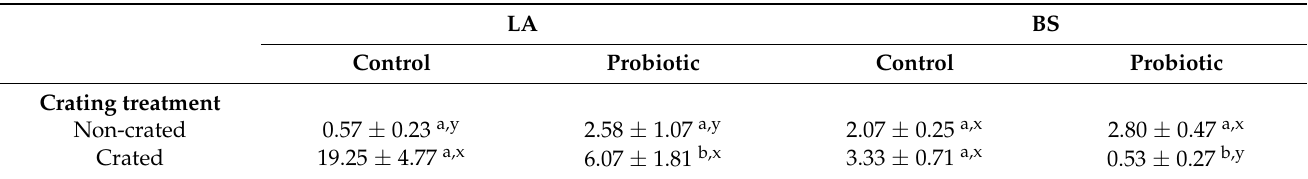
Table 7. Mean ( ± SEM) duration of latency to the first immobilisation (LA) (s) and frequency of body shaking (BS) where interaction between diet and crating treatment were significant in ducks on day 21. LA BS Control Probiotic Control